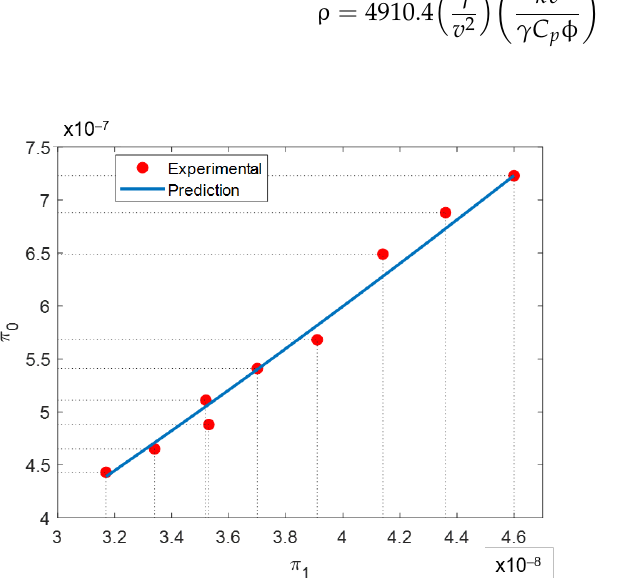
Figure 5. Experimental plot of π 0 (dependent) vs. π 1 (independent) dimensionless numbers. The correlation between π 0 and π 1 is an indication that dimensional analysis has succeeded in describing the physics of the SLM process [57].